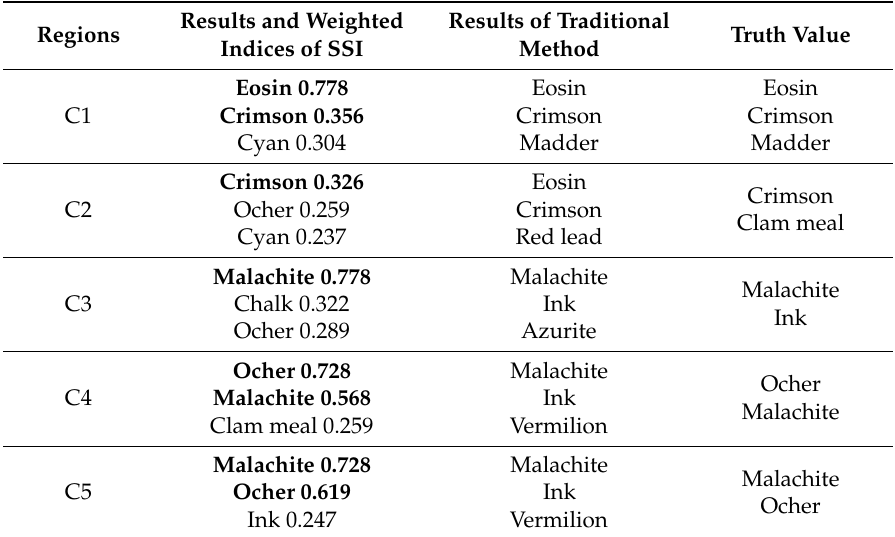
Table 7. Comparison of pigment identification in the five regions of the Chinese painting.